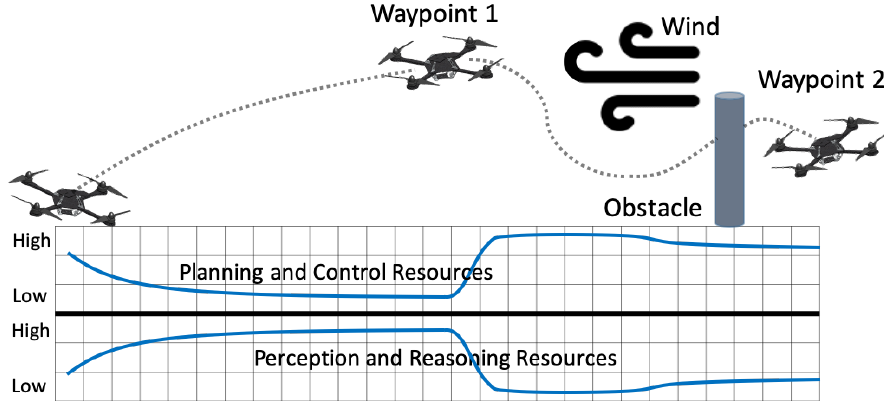
Figure 2. Dynamic resource reallocation of a